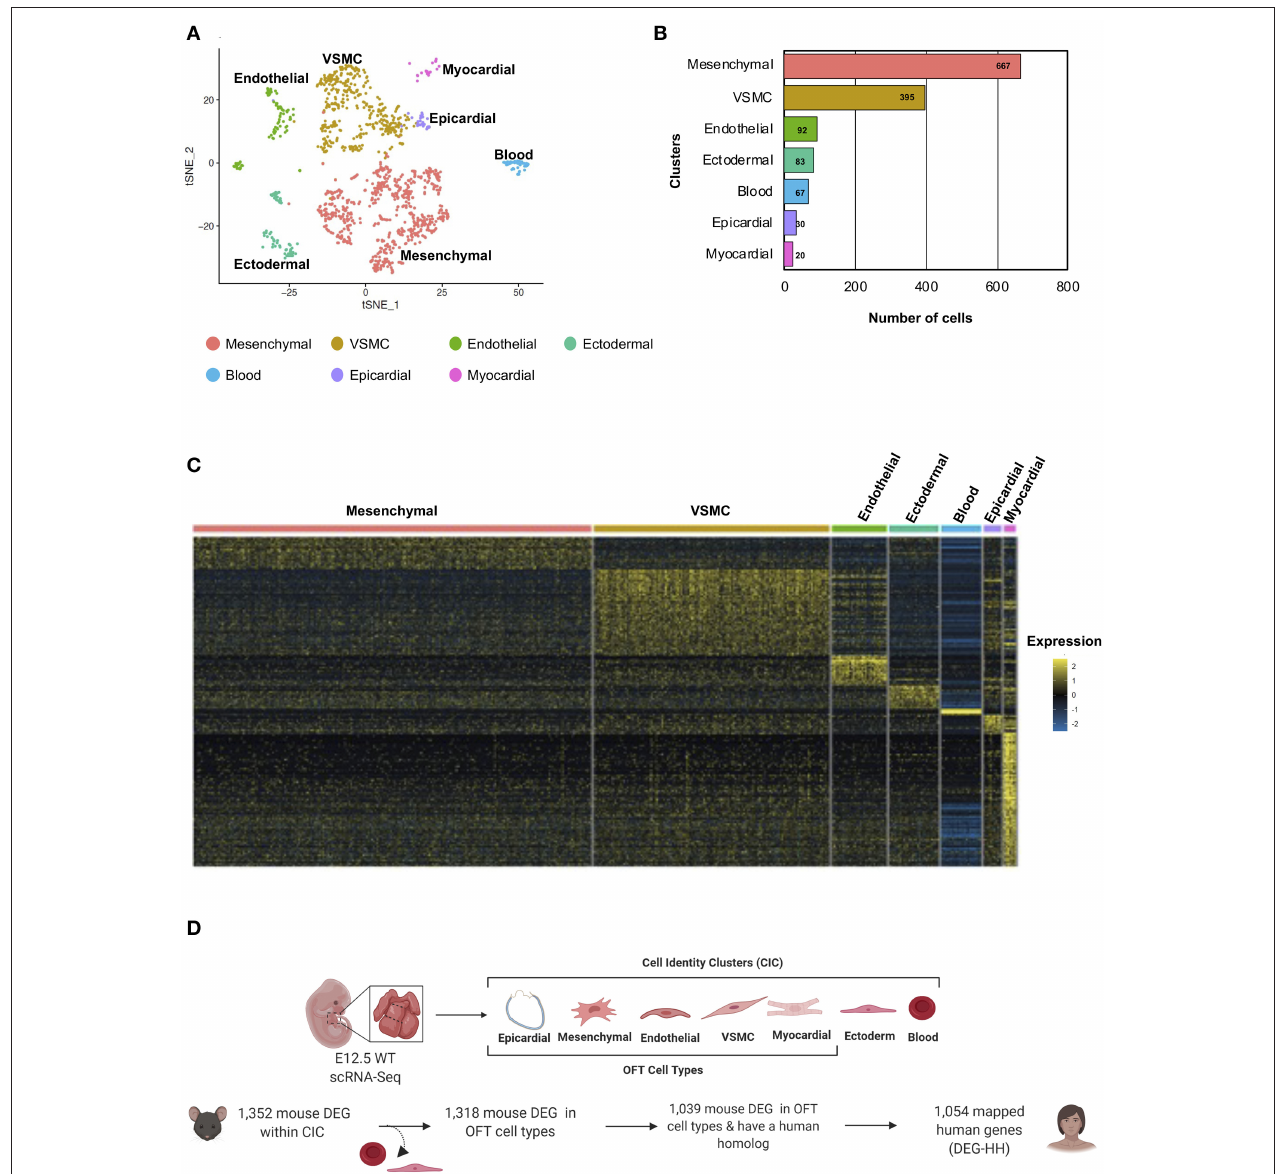
FIGURE 4 | Cellular classification of gene transcripts identified in bulk RNA-Seq utilizing scRNA-Seq analysis of the embryonic cardiac outflow tract. (A) tSNE plot of cells captured via scRNA-Seq is shown and classified according to cell identity markers. The identified subclusters are mesenchymal, vascular smooth muscle cells (VSMC), endothelial, ectodermal, blood, epicardial, and myocardial cells. (B) Raw count of cells within each cluster indicated that 1,354 cells were captured from the cardiac outflow tract. (C) Wildtype gene transcripts identified via bulk RNA-Seq were classified according to scRNA-Seq cell cluster profile; heatmap of overlapping genes is shown. (D) Schematic of how the DEG-HH gene list was generated. Differentially expressed genes that were also found to be expressed in the scRNA-Seq dataset were selected. These were filtered based on cell-type specificity and whether they possess a human homolog to generate a candidate list of 1,054 human genes. Figure 4D was generated on